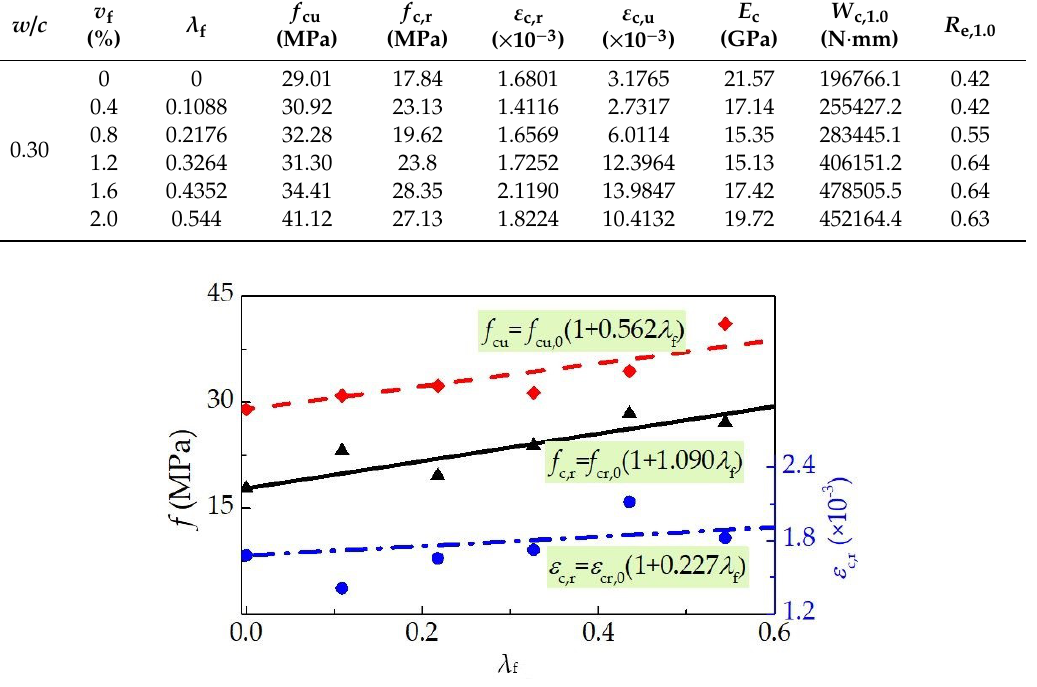
Table 4. Test result of compressive strength and toughness.